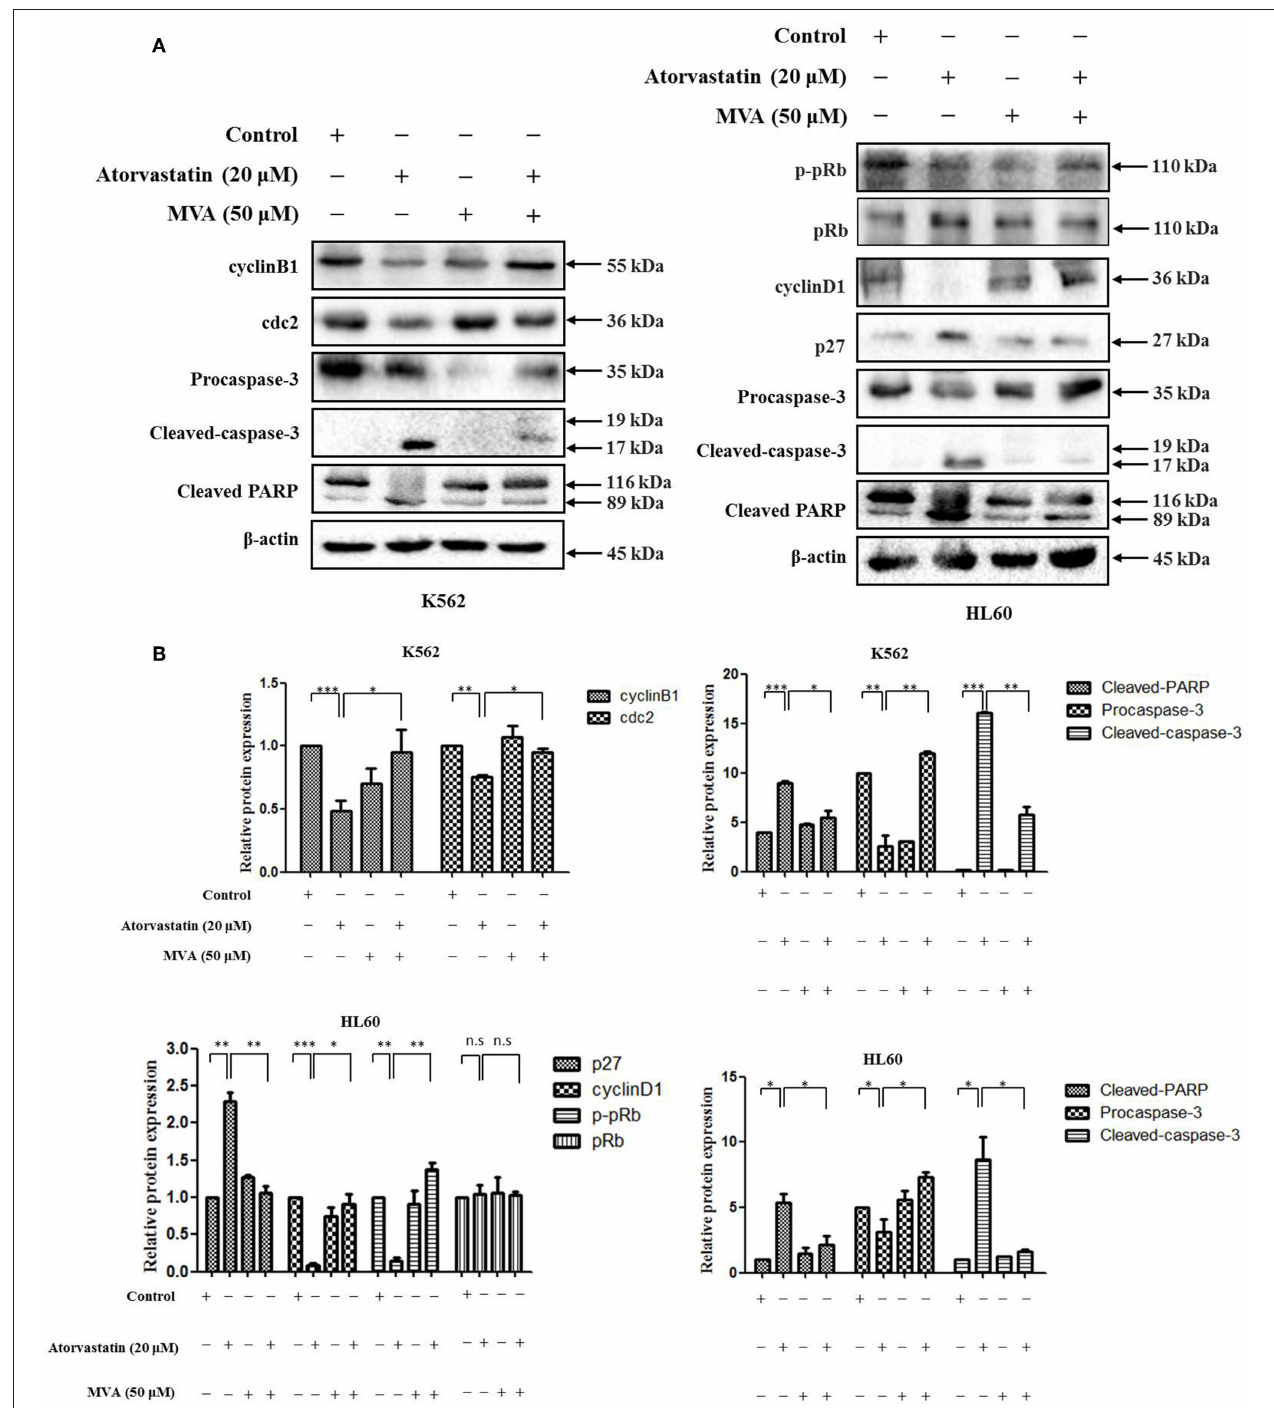
FIGURE 8 | Atorvastatin exerts antileukemia activity via MVA-YAP axis in K562 and HL60 cells. K562 and HL60 cells were incubated with Atorvastatin (0 and 20 µ M) in presence or absence of exogenous MVA (50 µ M) for 48h. (A) The levels of cyclinB1 and cdc2 in K562 cells, as well as cyclinD1, p27, p-pRb, and pRb in HL60 cells, caspase-3 and PARP in both cell lines were determined by western blot. (B) Bar graphs show the relative levels of cyclinB1, cdc2, cyclinD1, p27, p-pRb, pRb, caspase-3, and PARP, Data are presented as mean ± SD of three independent experiments. * p < 0.05, ** p < 0.01, *** p < 0.001 vs. control. n.s., not significant.